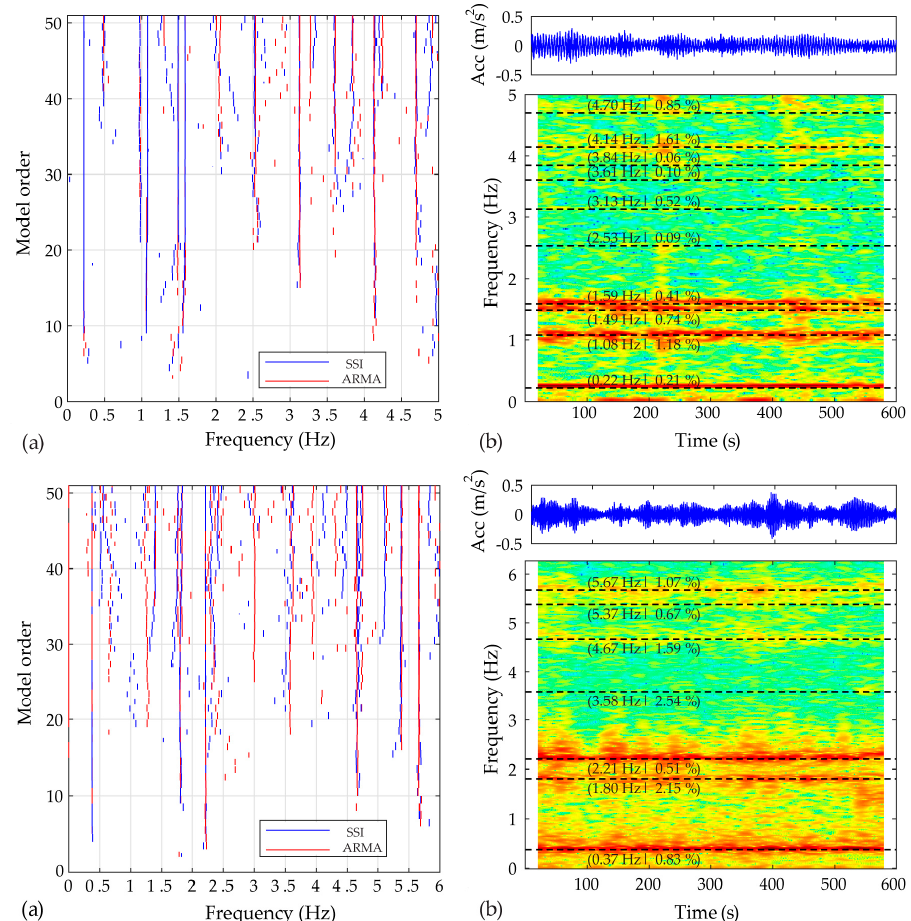
Figure 6. Dynamics of the parked WTs (Case A up and Case B bottom): ( a ) Stabilization plot for the stationary ARMA and SSI methods (model orders from 2 to 50); ( b ) Spectrogram and estimated natural frequencies and damping ratios based on an ARMA(32,32) model for Case A and ARMA(18,18) model for Case B (For interpretation of the references to color , the reader is referred to the web version of this article).